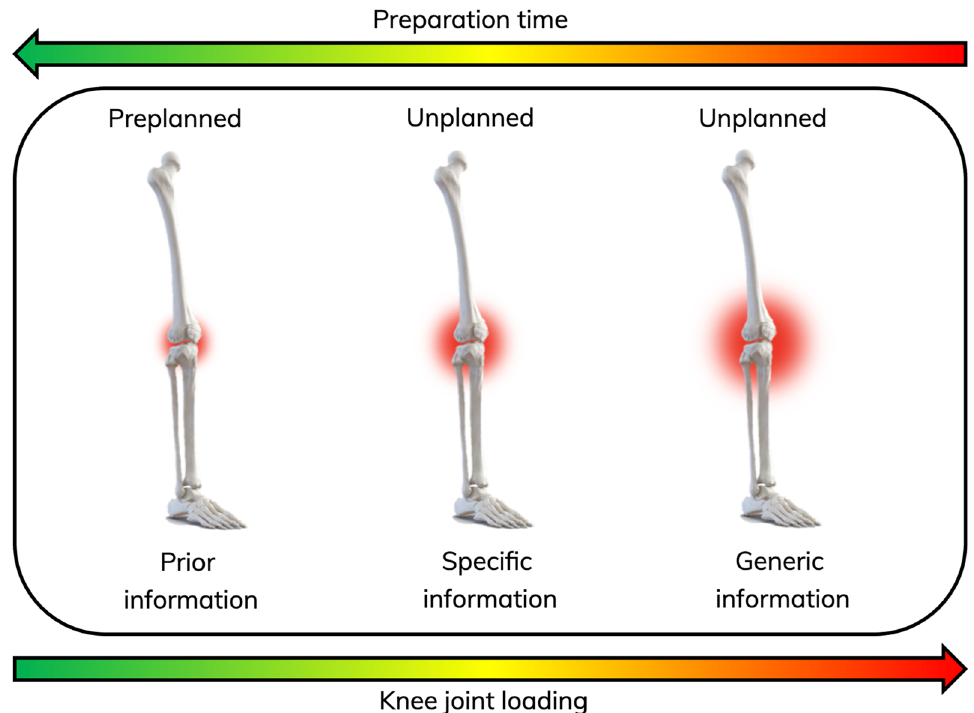
Fig. 6 Knee joint loading continuum in response to different information sources. Data from Lee et al.